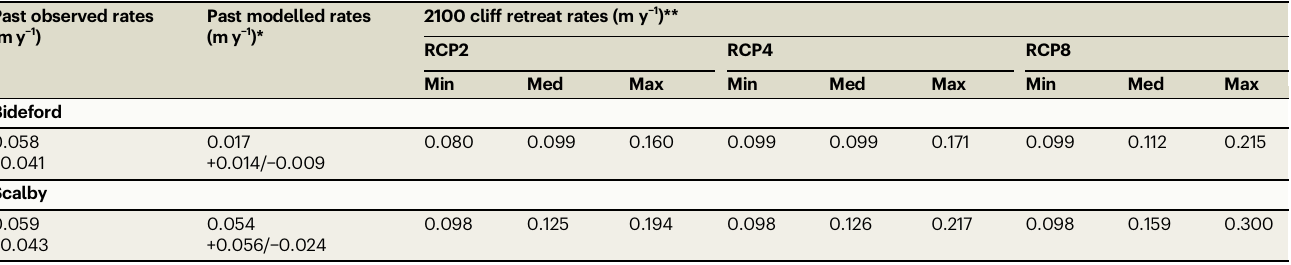
Table 1 | Past cliff retreat rates and future Representative Concentration Pathway RCP2, RCP4 and RCP8, minimum, medium and maximum 2100 forecast cliff retreat rates Past observed rates (my − 1